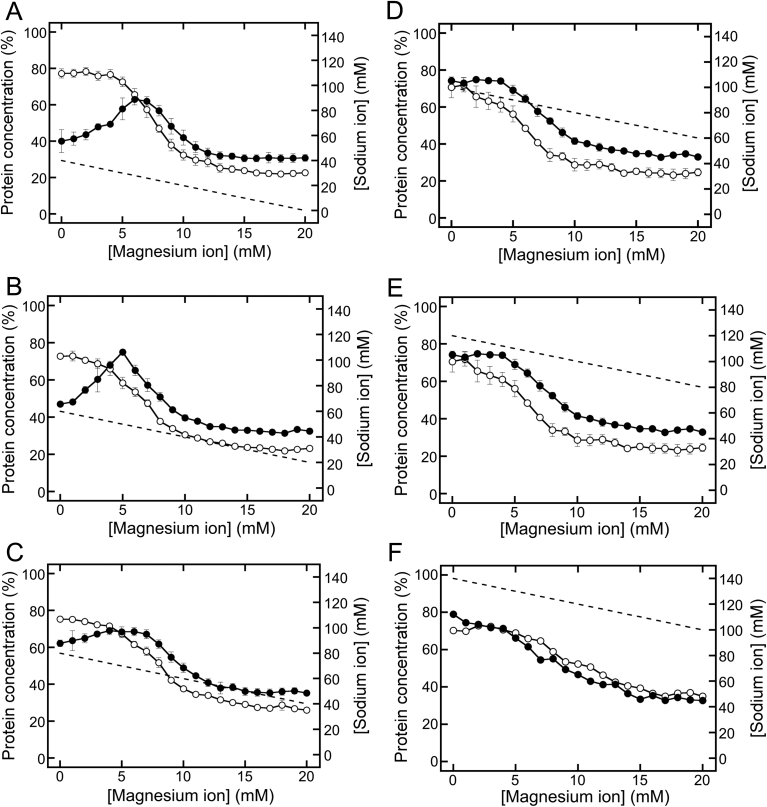
Changes in urea-soluble proteins prepared in the presence of various fixed Cl− concentrations. MgCl2/NaCl mixtures were added to soymilk with various cation concentrations and various fixed Cl− concentrations. The final Mg2+ concentration was in the range of 0 mM–20 mM in the presence of chloride ions at a constant concentration of 40 (A), 60 (B), 80 (C), 100 (D), 120 (E), or 140 mM (F). Open and closed circles represent residual protein concentrations and urea-soluble protein concentrations, respectively. The dashed lines represent the Na+ concentration. The data are shown as the averages ± standard deviations of three independent experiments.